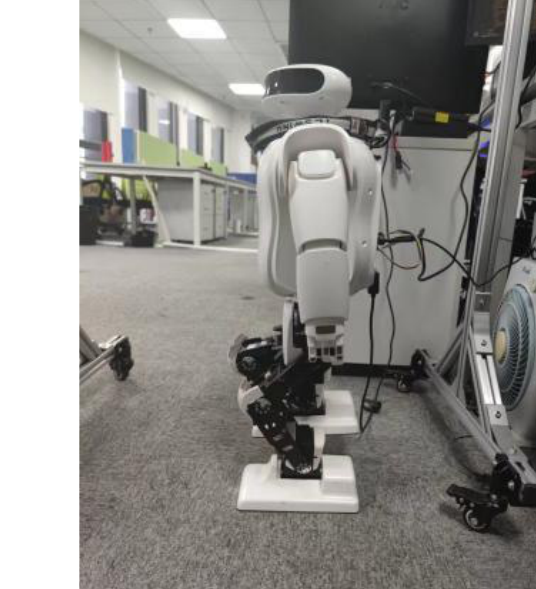
Figure 8. Torque feed forward for Roban standing on a single leg.